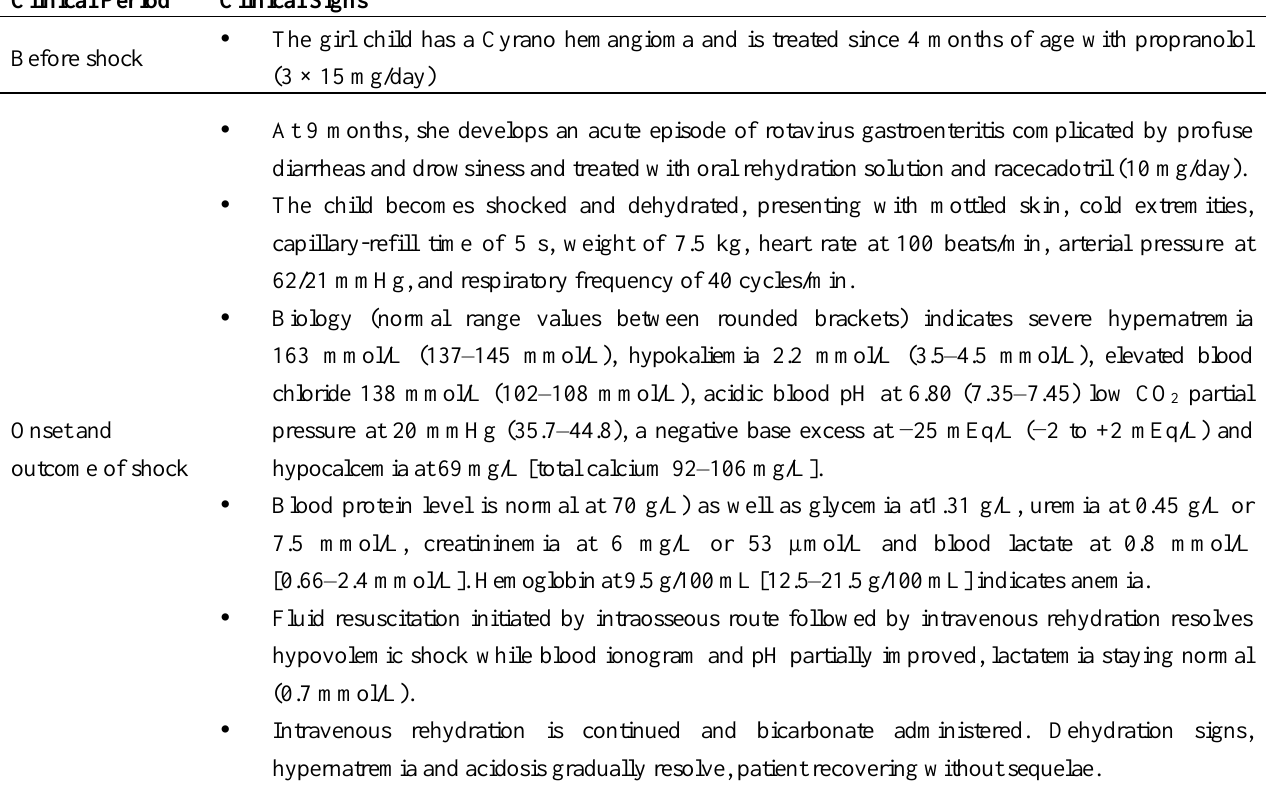
Table 1. Main clinical features and therapeutic measures in a child undergoing a hypovolemic shock caused by dehydration a